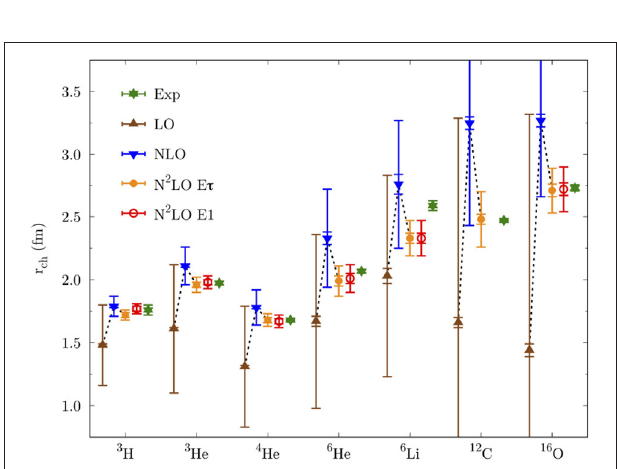
FIGURE 7 | Same as Figure 6 (right) but for radii of nuclei up to 16 O. Reprinted from Lonardoni et al. [ 99] with permission from the American Physical